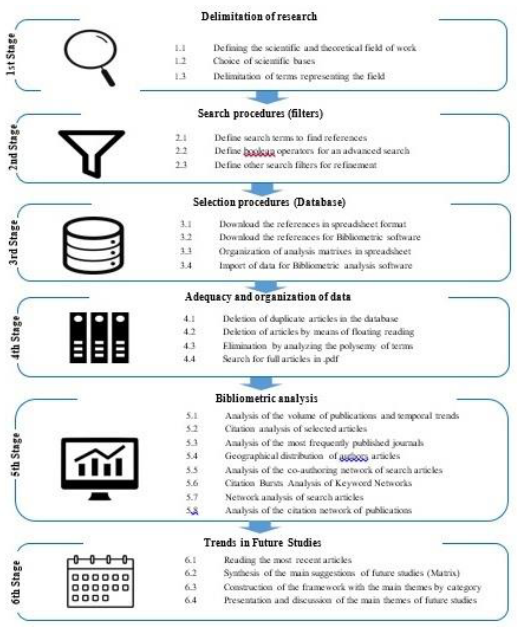
Figure 1. Research Framework Source: Prado et al.